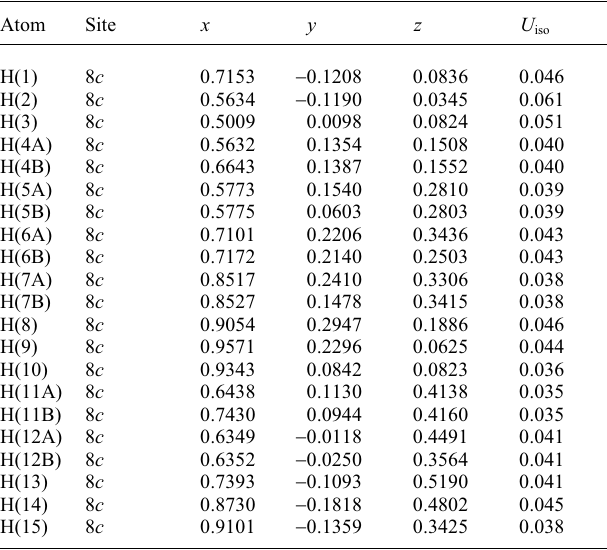
Table 2. Atomic coordinates and displacement parameters (in Å 2 )